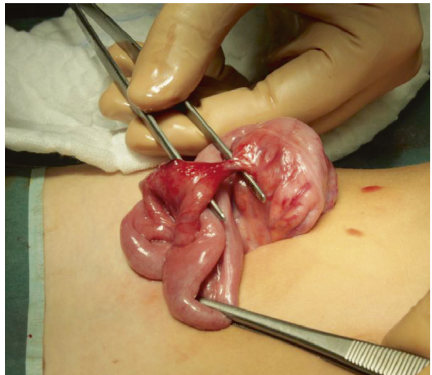
Figure 1: Ileocecal fistula.